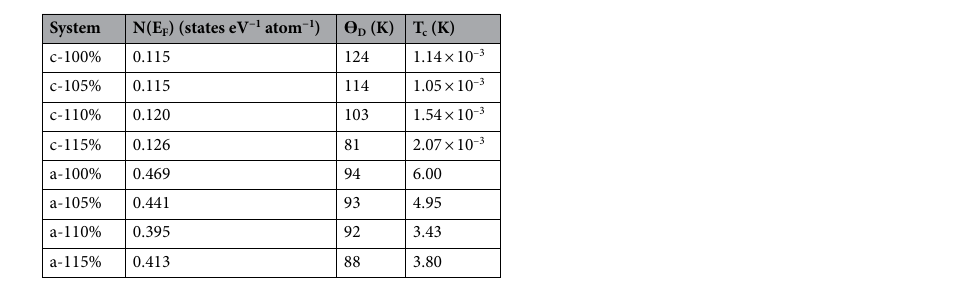
Figure 7 are a graphical representation of our results for a) N ( E F ), b) θ D , and c) T c The general behavior is that the superconducting transition temperature varies minimally (from 1.14 to 1.05 mK, to 2.07 mK) for the crystalline structures as they expand, whereas it decreases notably (from 6.00 to 3.43 K to increase again) as the amorphous structures expand. It is surprising to see the similarity in the behavior of the eDoS at the Fermi level and the estimated T c of the samples. On the other hand, the behavior of θ D indicates that the value for the amorphous and for the crystalline materials decrease as they expand. Table 2 gives the numerical values for the graphs of Fig. 7. The values for the Debye temperatures of 124 K for the c-100% should be compared with 129 K calculated in Ref. 10 . Also, contrast 94 vs. 100 K 10 for the a-100%. The value of N(E F ) for the crystal diminishes due to the well-known existence of a pseudo gap at the Fermi level (Fig. 3).